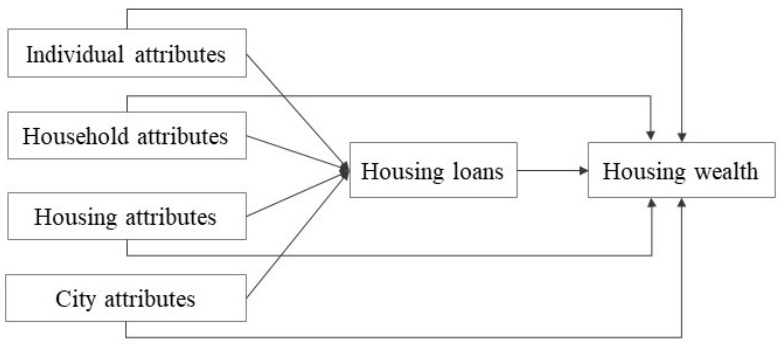
Figure 1. The framework of generalized structural equation model.